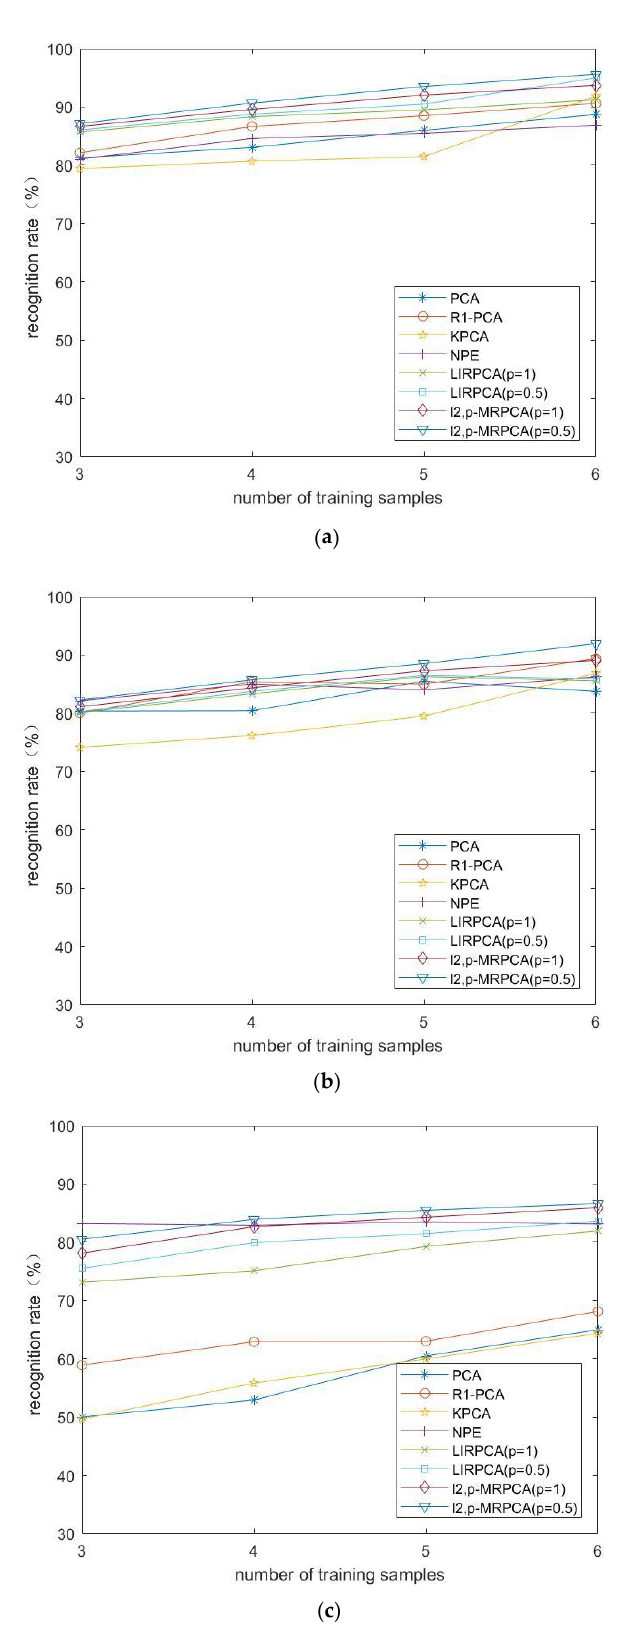
Figure 2. Recognition rate of PCA, 𝑅 1 -PCA, KPCA, NPE, LIRPCA ( 𝑝 = 0.5 ), LIRPCA ( 𝑝 = 1 ), 𝑙 2,𝑝 - MRPCA ( 𝑝 = 0.5 ), 𝑙 2,𝑝 -MRPCA ( 𝑝 = 1 ) on ORL database ( a ) original image ( b ) occlusion block = 5 × 5 ( c ) occlusion block = 10 × 10. block = 5 × 5 ( c ) occlusion block = 10 ×